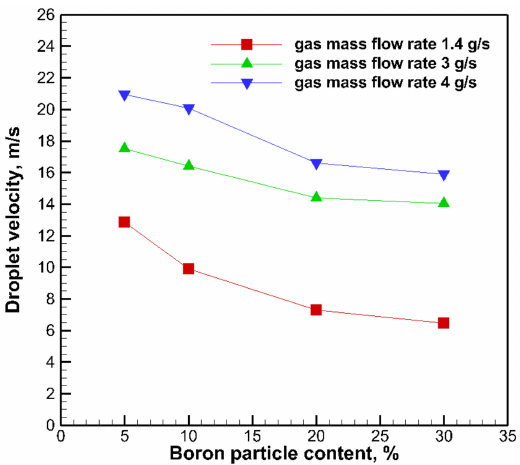
Figure 11. Droplet velocity vs. boron particle